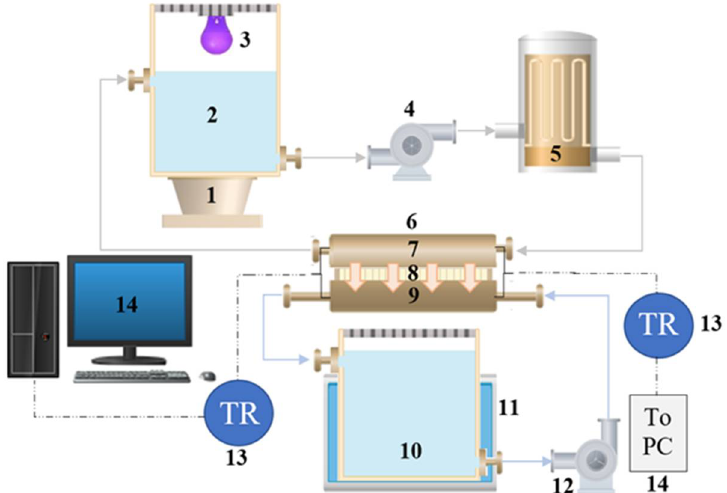
Figure 9. Hybrid system diagram: (1) magnetic stirrer; (2) feed tank; (3)UV-lamp; (4) feed pump; (5) heating unit; (6) membrane cell; (7) feed compartment; (8) PVDF membrane; (9) permeate compartment; (10) permeate tank; (11) cooling jacket; (12) permeate pump; (13) thermocouples; (14) PC data acquisition system.